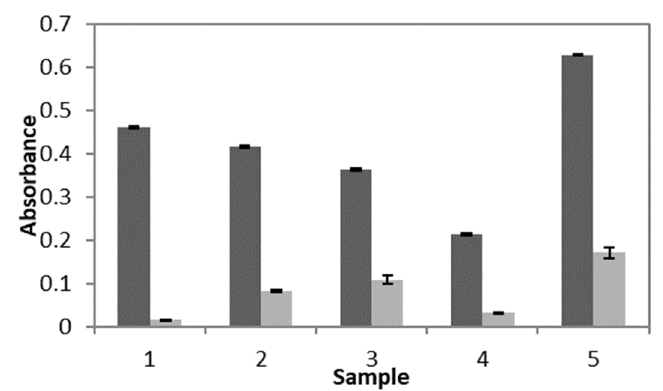
Figure 6. Absorbance readings at 350 nm of pHEMA (BAC, 3AAPBA) nanoparticles in the presence of water ( ■ ) and 10 mM DTT ( ■ ). Sample numbers correspond to samples C1 (1), C2 (2), C3 (3), C4 (4), and C5 (5) from Table 2. Error bars were obtained from the standard error of 9 control samples and 27 test samples. For all samples p < 0.0001.